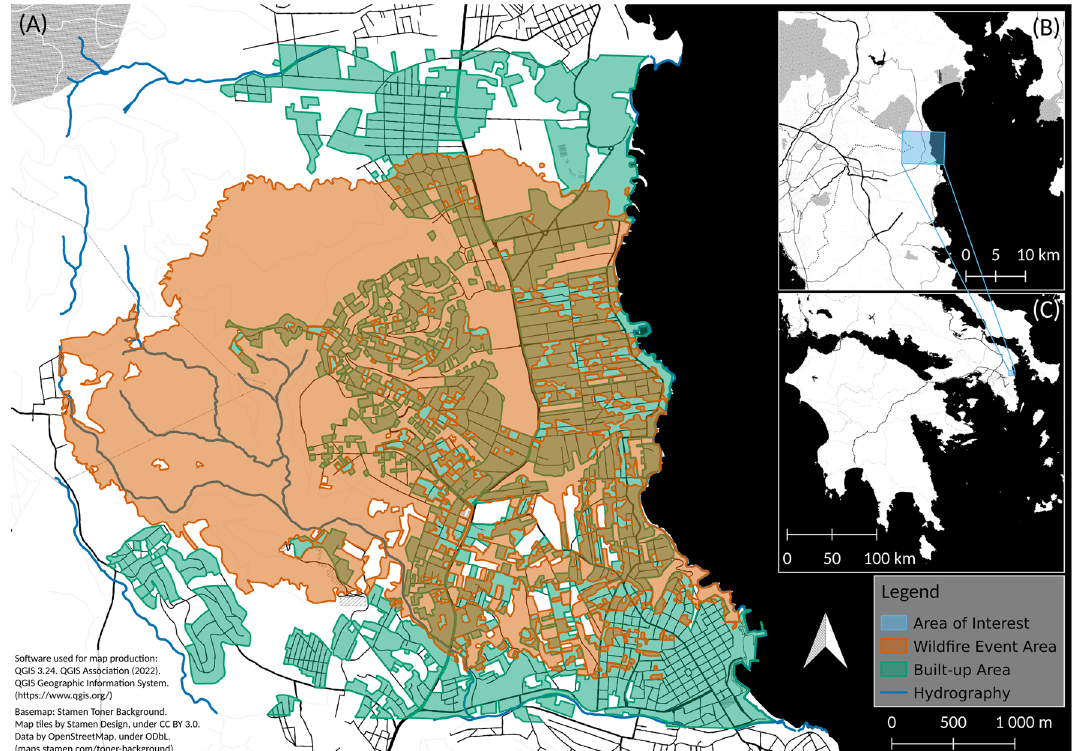
Figure 2. Map of the area under study showing the extent of the wildfire as of 26 July 2018 16:40 (UTC). The main map ( A ) shows the area affected by the wildfire event and the built-up area. Data is taken from the Copernicus Emergency Management Service (EMSR300) 54 . The inlets show the area of interest in a broader context. ( B ) Shows the location of the study area around Mati on the east coast of Attica. ( C ) Displays the location of the area of interest in the Western